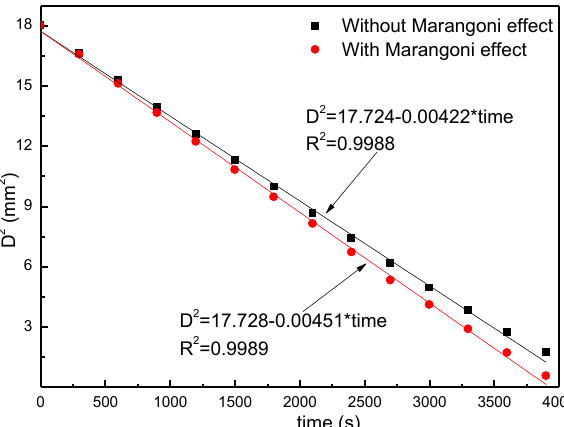
Figure 3. Variation of the squared droplet diameter with evaporation time.